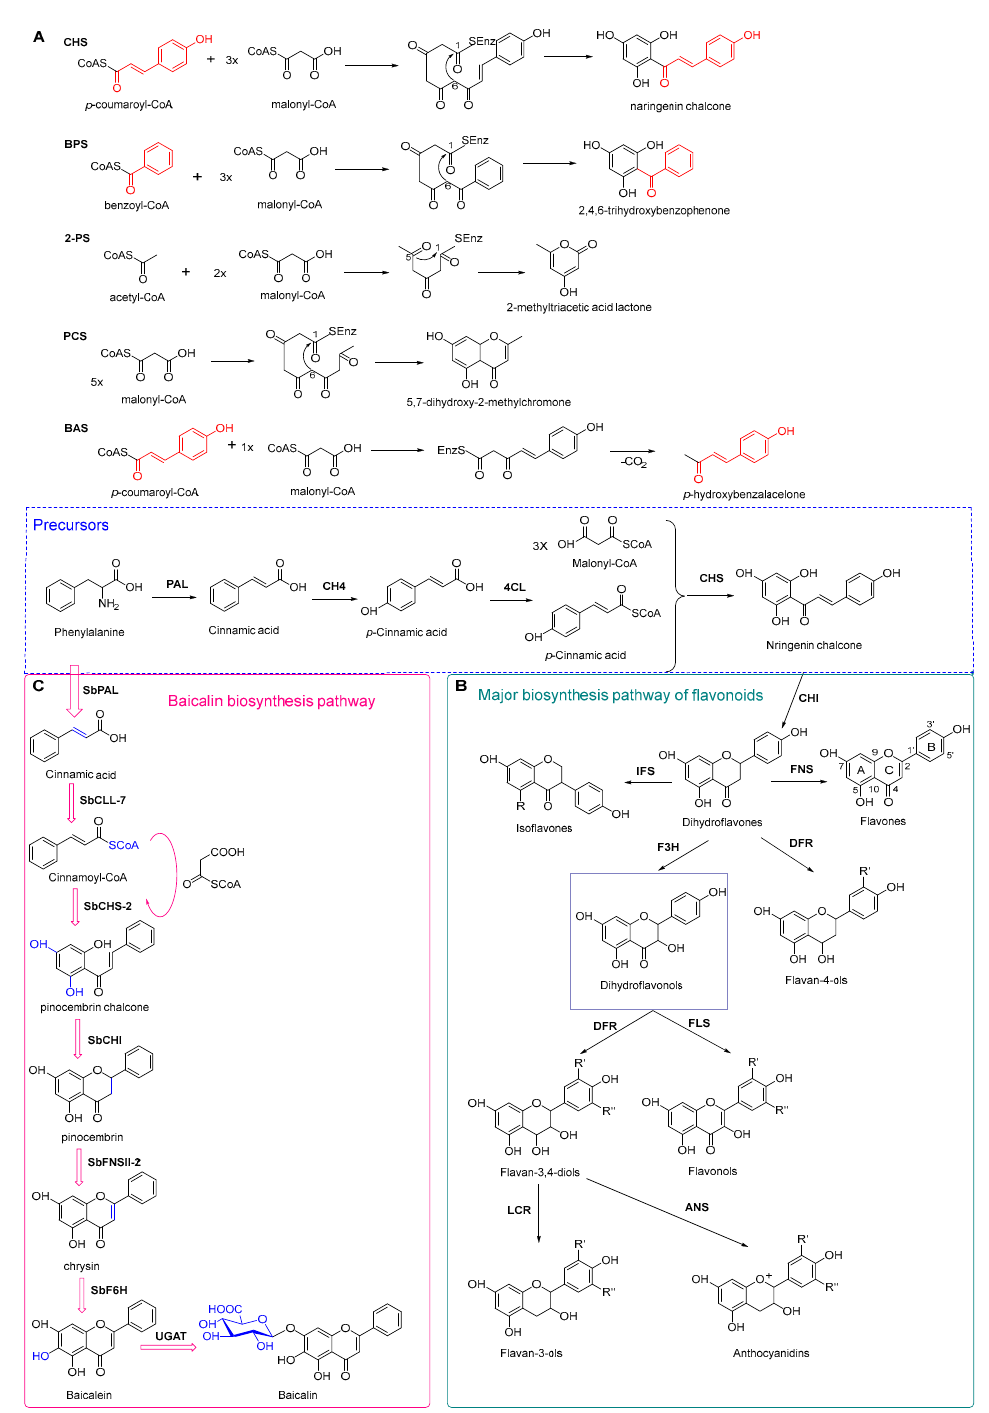
Figure 7. ( A ) Typical reactions catalyzed by plant type III PKSs. ( B ) Main skeleton types of plant- derived flavonoid compounds. ( C ) Biosynthetic pathway of flavonoid antimicrobial agent baicalin. CHS, chalcone syntheses; BPS, benzophenone synthase; 2-PS, 2-pyrone syntheses; PCS, pentaketide chromone synthase; BAS, benzalacetone synthase; PAL, phenylalanine ammonia lyase; CH4, cinnamic acid 4-hydroxylase; 4CL, 4-coumarin CoA ligase; CHS, chalcone synthase; CHI, chalcone isomerase; IFS, isoflavone synthase; FNS, flavone synthase; F3H, flavanone 3-hydroxylase; DFR, dihydroflavonol 4-reductase; FLS, flavonol synthase; ANS, anthocyanidin synthase; LCR, leucoanthocyanidin reduc- tase; SbCLL-7, cinnamate CoA ligase; SbCHS-2, pinocembrin chalcone synthase; SbFNS II-2, flavone synthase; SbF6H, flavone 6 hydroxylase; UGAT, UDP-glucuronic acid transferase